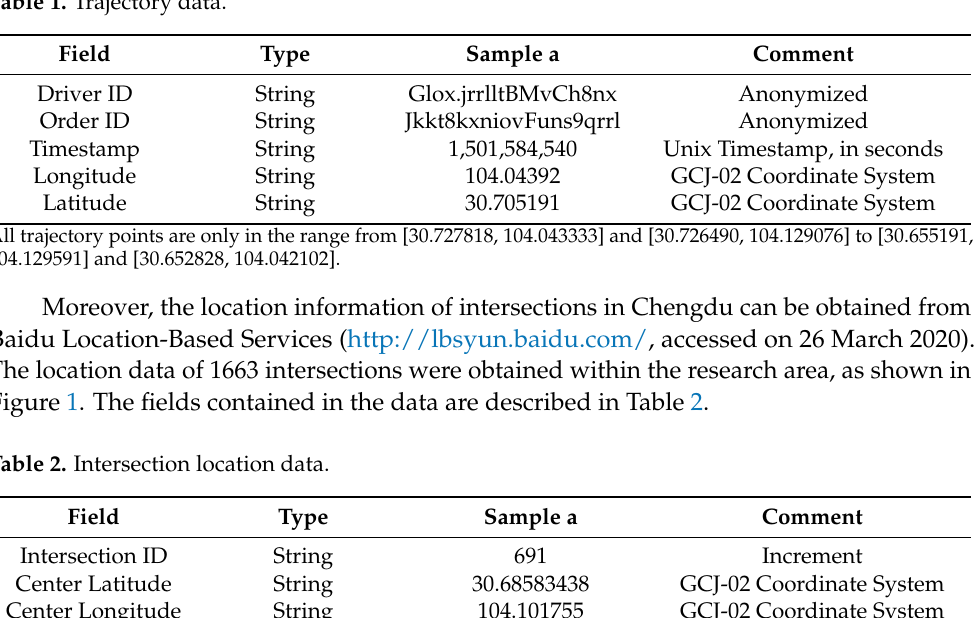
Figure 1. Trajectory data and intersection data. Table 1. Trajectory data.